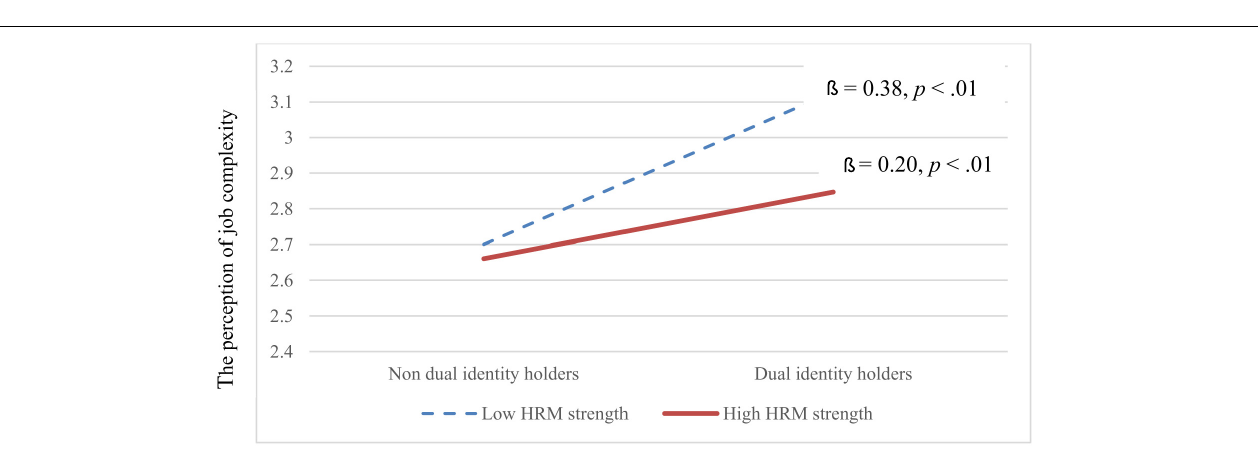
FIGURE 4 | Cross-level moderating effect of HRM strength on the relationship between dual-identity holders and the perception of job complexity.